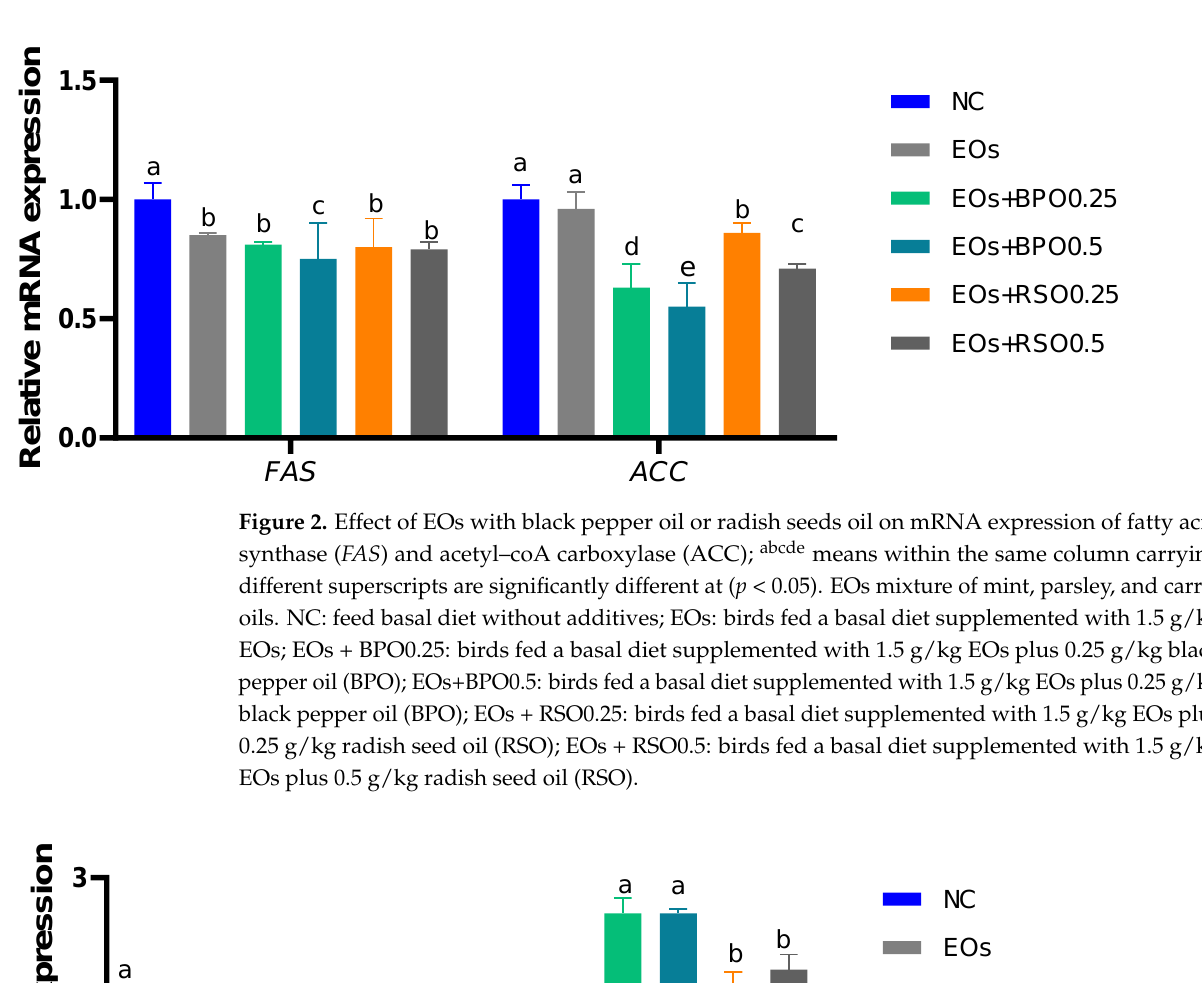
The expression patterns of IL-10 and IgA genes are described in Figure 3. The results revealed that all groups supplemented with EOs exhibited higher mRNA expression lev- els of IL-10 and IgA genes ( p < 0.05) when compared with the NC group. Additionally, the group supplemented with EOs plus BPO (at both levels), followed by 0.5 g/kg of RSO, showed a significant increase in ( p < 0.05) mRNA expression of IL-10 and IgA genes.